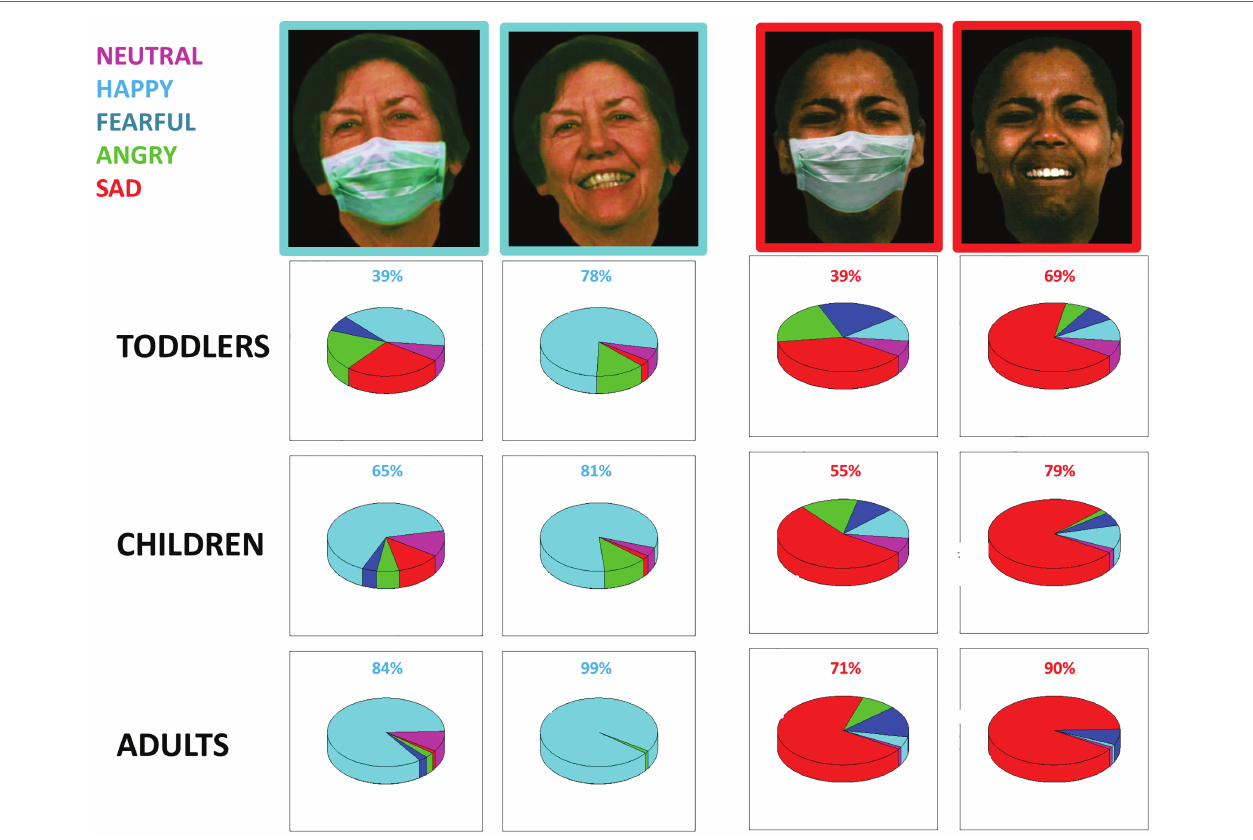
FIGURE 2 | Responses given by toddlers, children, and adults for two exemplar emotions with and without mask: happiness (left) and sadness (right). Percentage of the answer is reported for “Sad” (red), “Happy” (cyan), “Fearful” (blue), “Angry” (green), and “Neutral” (violet). Face images have been obtained from the ER-40 color emotional stimuli public database (Gur et al., 2002; Pinkham et al.,